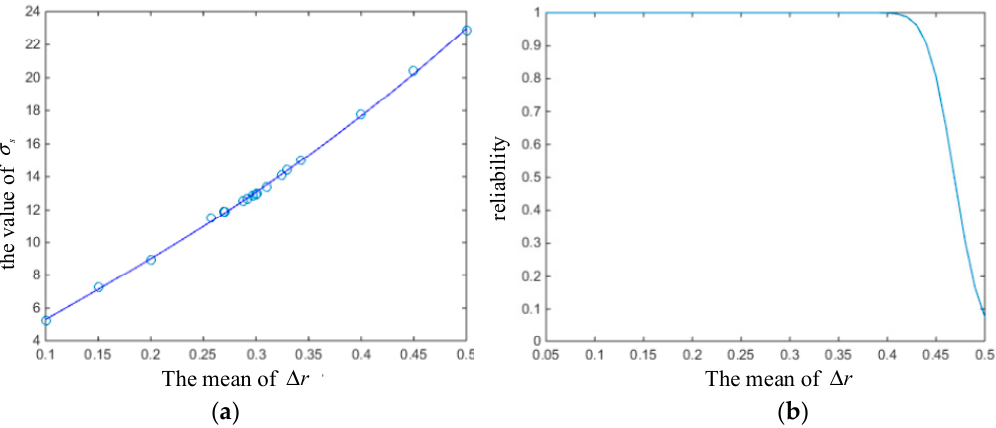
Δ . Figure 8. ( a ) Compressive stress and ( b ) reliability with varying compression quantity ∆ r .